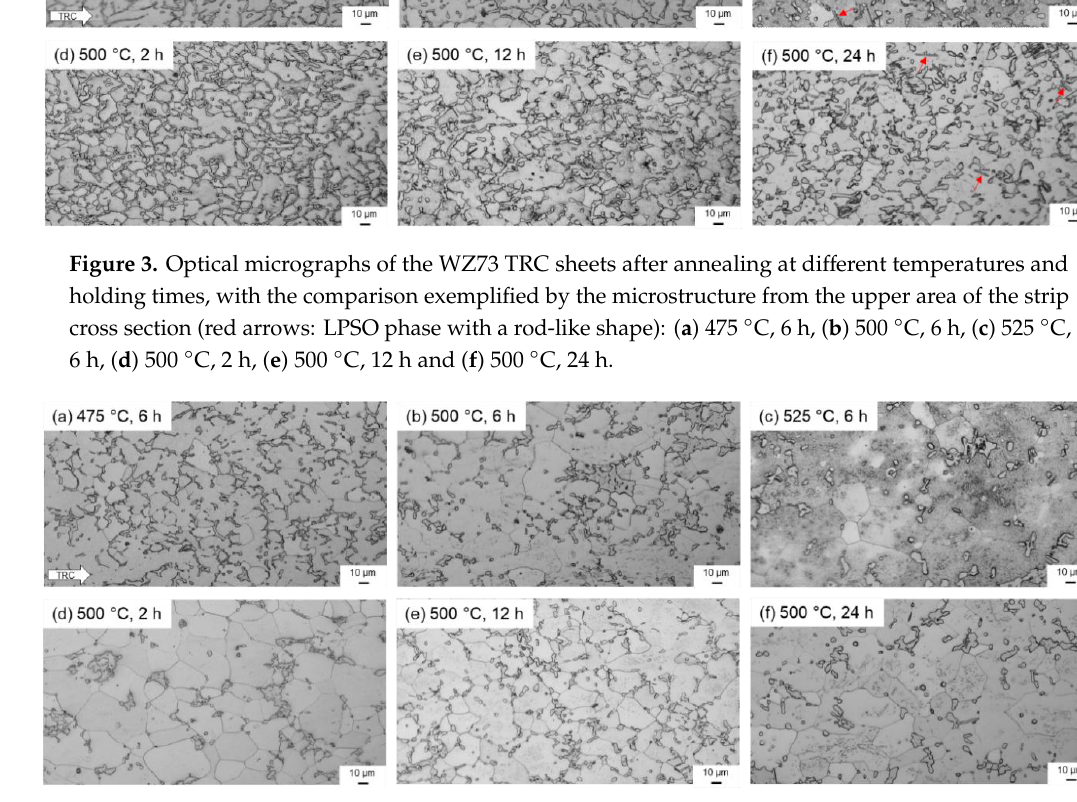
Figure 4. Optical micrographs of the WZ73 TRC sheets after annealing at different temperatures and holding times, in the mid-thickness of the sheet: ( a ) 475 °C, 6 h, ( b ) 500 °C, 6 h, ( c ) 525 °C, 6 h, ( d ) 500 °C, 2 h, ( e ) 500 °C, 12 h and ( f ) 500 °C, 24 h.